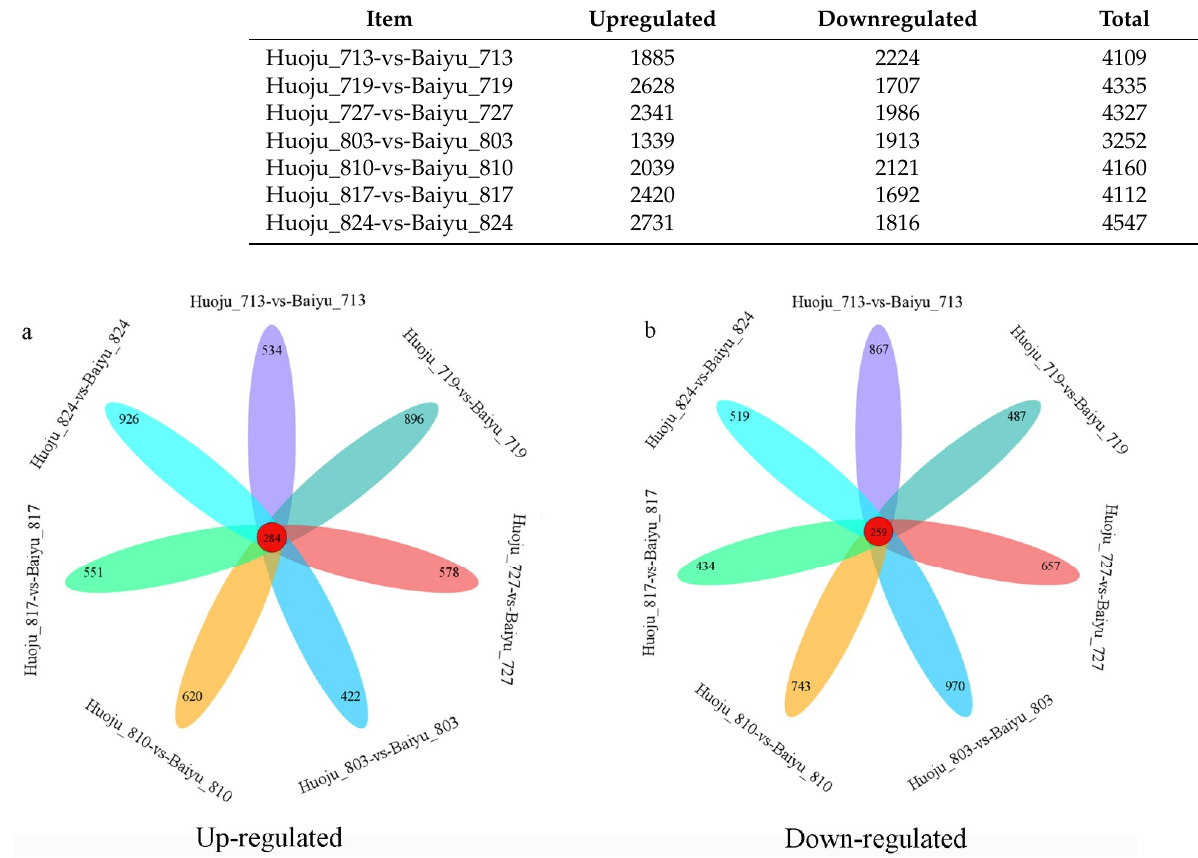
Figure 3. Venn diagram showing numbers of upregulated ( a ) and downregulated ( b ) DETs in each sampling period. Note: Arabic numbers in center indicate the DETs common to seven libraries; Arabic numbers in margin indicate the DETs individually owned in each library, respectively.